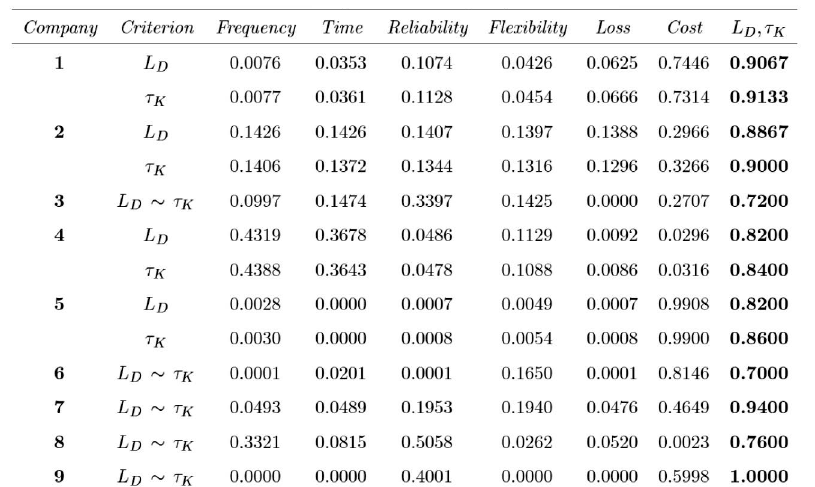
Weights for each model and Kendall